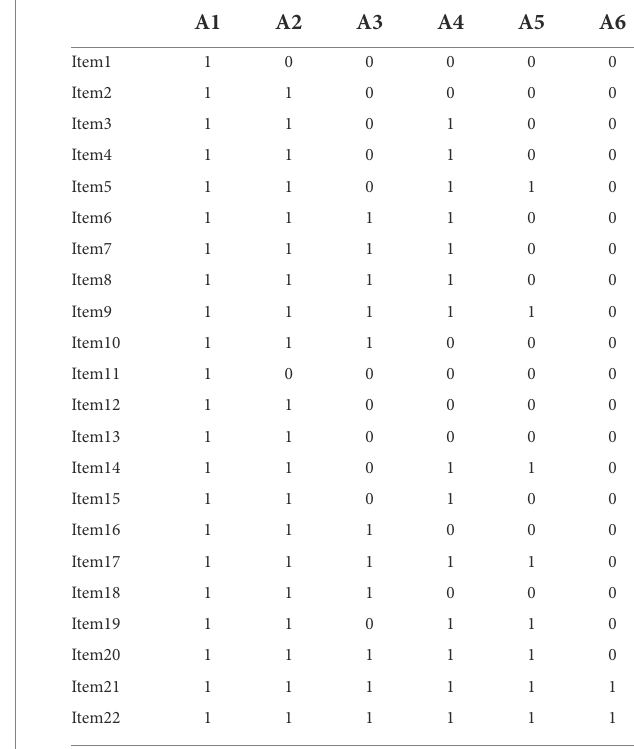
TABLE 3 Final Q-matrix of data analysis